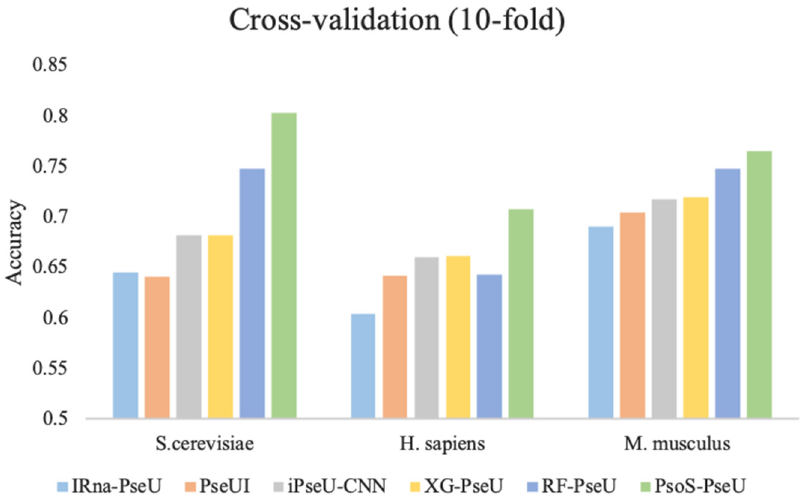
Figure 6. Performance evaluation of the PsoEL-PseU predictor and five state-of-the-art predictors on three benchmark datasets. The legend represents the names of the six state-of-the-art predictors.